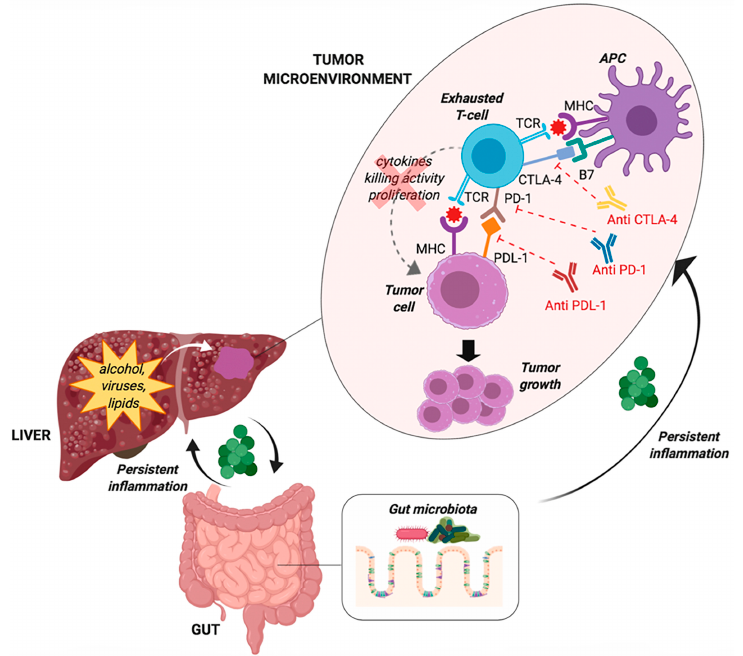
Figure 1. Mechanisms of immune system paralysis in patients with hepatocellular carcinoma (HCC). Inflammatory damage triggered from various factors (alcohol, hepatitis viruses, lipid accumulation, etc.) and from the gut microbiota is involved in the pathogenesis of HCC both directly and indirectly, through T-cells exhaustion. Exhausted T-cells express inhibitory receptor proteins and have a diminished capacity to produce cytokines, proliferate and kill cells. Indeed, antigen presenting cells (APC) and tumour cells express inhibitory molecules such as programmed cell death ligand 1 (PDL- 1) and B7 that interact with the surface antigens programmed cell death 1 (PD-1) and cytotoxic T- lymphocyte-associated protein 4 (CTLA-4) on T-lymphocytes, inhibiting the downstream signalling